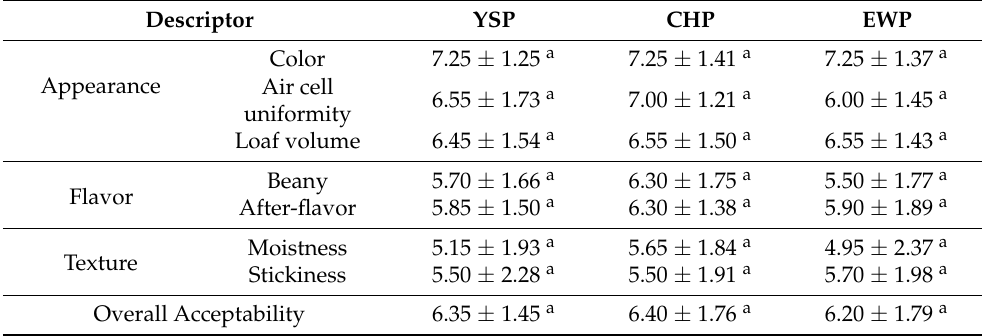
Table 5. Sensory analysis of aquasoya muffins formulated with yellow soybean powder (YSP), chickpea powder (CHP), and egg white powder (EWP).